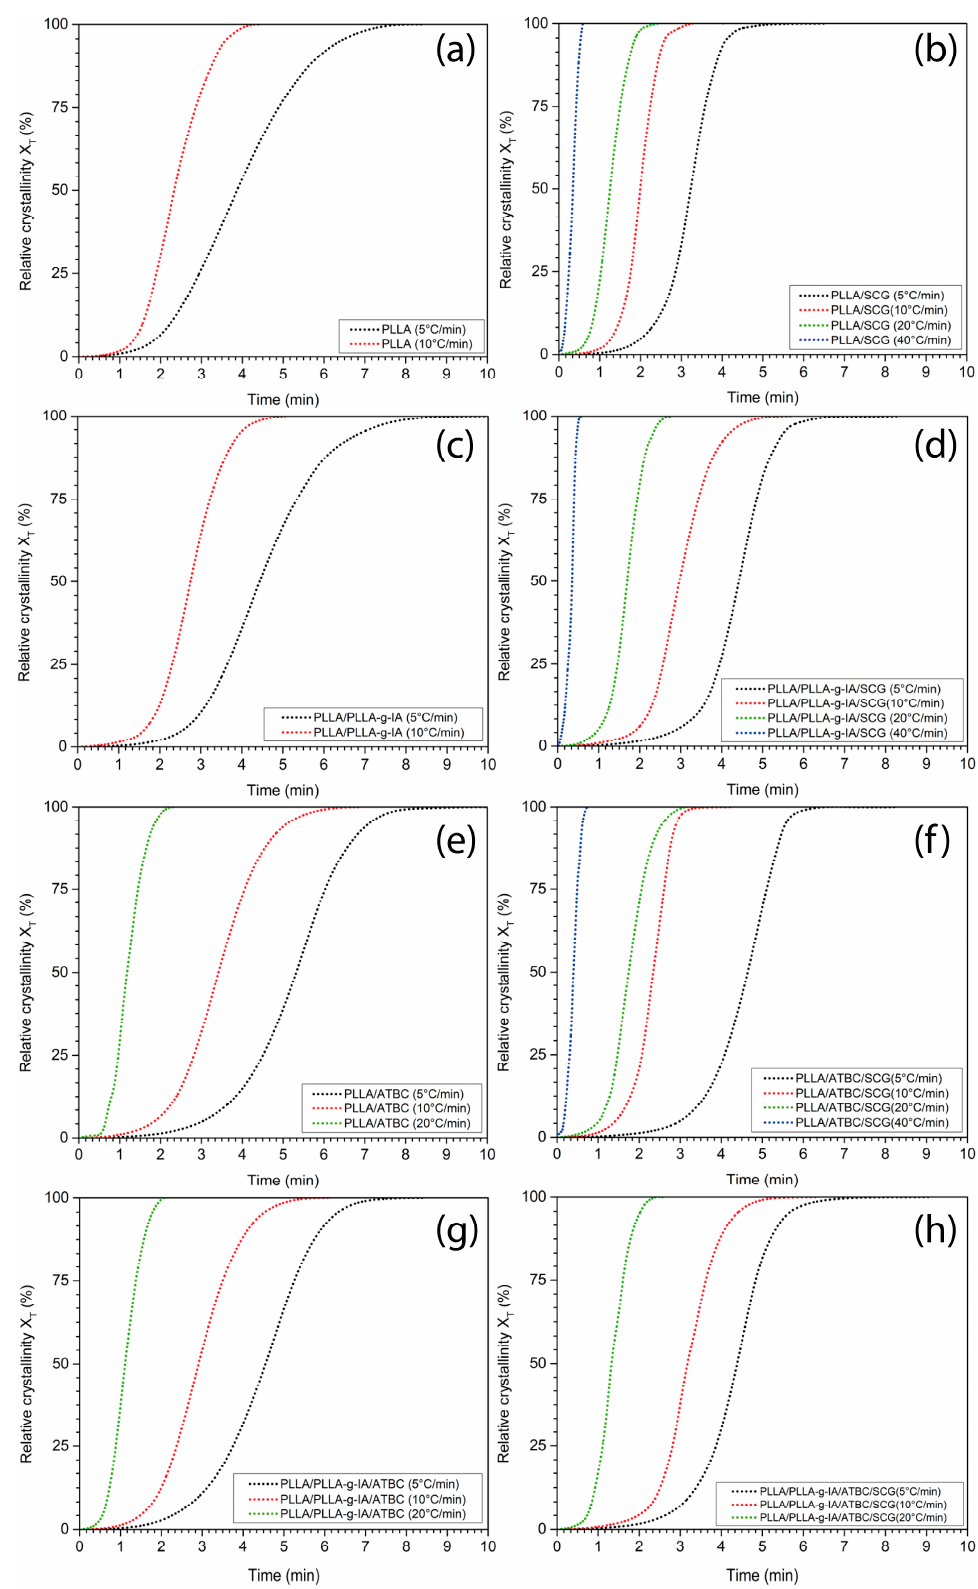
Figure 6. Plots of X T as a function of time during the cooling rates 5, 10, 20, and 40 °C/min for ( a ) neat PLLA, ( b ) PLLA/SCG, ( c ) PLLA/PLLA-g-IA, ( d ) PLLA/PLLA-g-IA/SCG, ( e ) PLLA/ATBC, ( f ) PLLA/ATBC/SCG, ( g ) PLLA/PLLA-g-IA/ATBC, and ( h ) PLLA/PLLA-g-IA/ATBC/SCG.